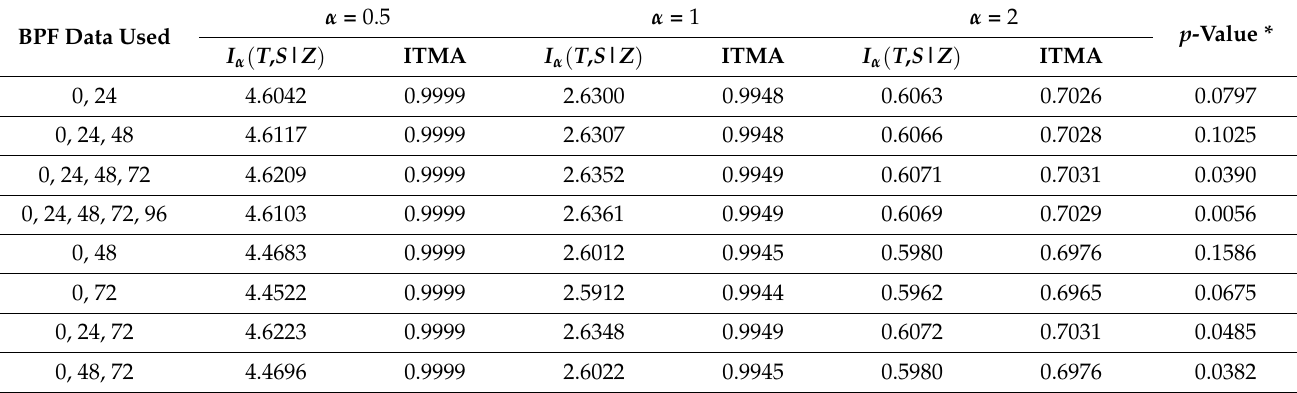
Table 2. H-C Mutual Information and ITMA by Different Longitudinal